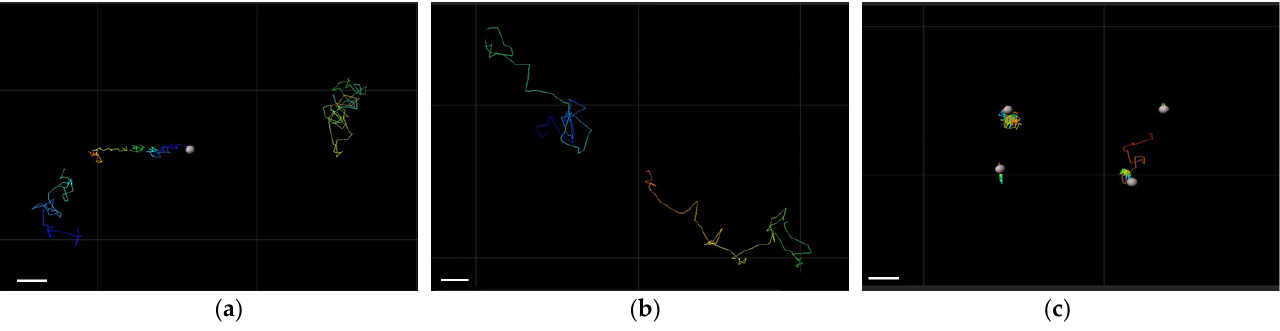
Figure 1. Stability of nanoparticles under simulated physiological conditions (PBS, pH 7.4, containing papain, 37 °C): P[KF] L nanoparticles with initial D H of 200 ± 20 nm; P[KF] D,L nanoparticles with initial D H of 110 ± 10 nm.